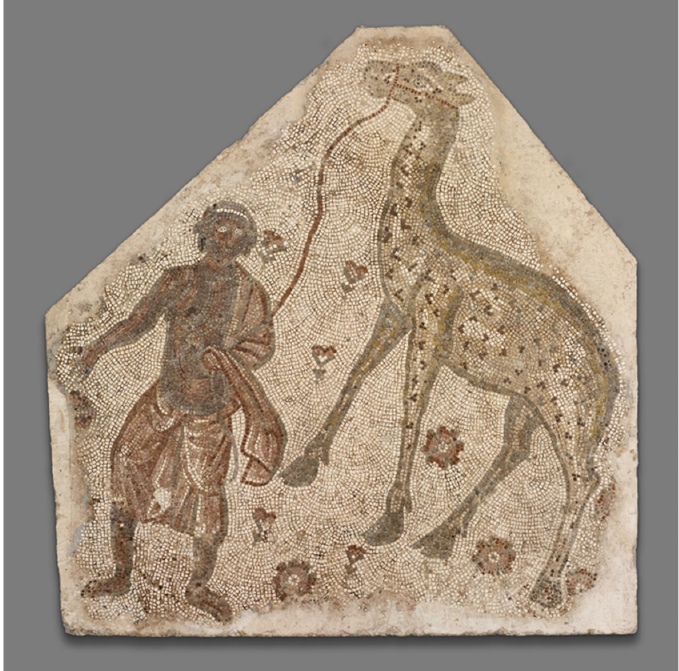
Figure 15. Mosaic Fragment with Man Leading a Giraffe , 5th century CE. Byzantine; Syria or Lebanon. Stone in mortar; 170.8 × 167 × 6.35 cm (67 1/4 × 65 3/4 × 2 1/2 in.). The Art Institute of Chicago, Gift of Mrs. Robert B. Mayer, 1993.345.